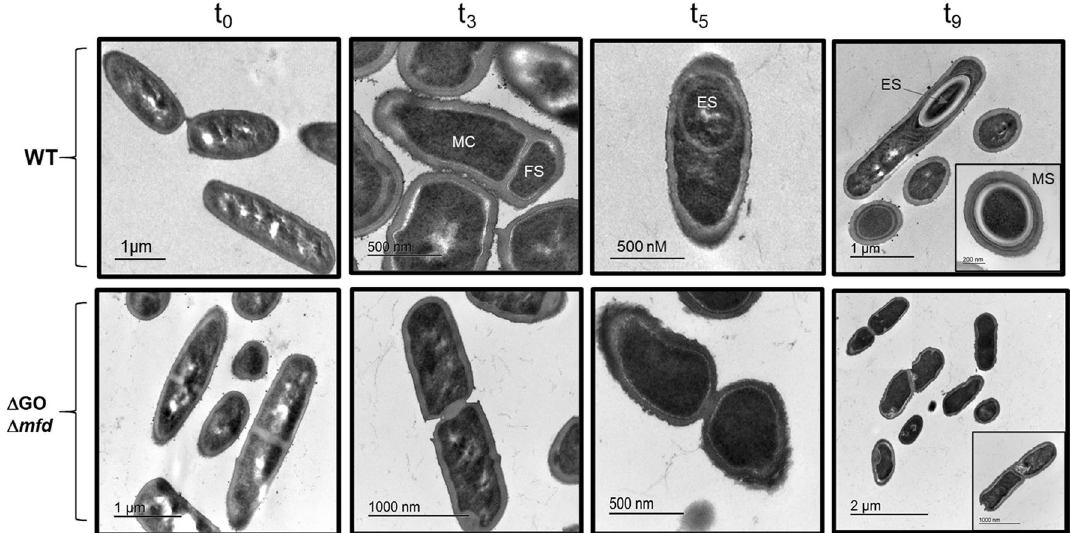
Figure 7. Transmission electron microscopy of sporulation stages of B. subtilis strains with a wild type (WT) or ∆ mfd ∆GO genotype. The strains indicated were induced to sporulate in DSM. At the stages indicated (t 0 , t 3 , t 5 and t 9 ), cells were collected, fixed and analyzed by TEM as described in “Materials and methods” section. Red arrows indicate: MC mother cell, FS forespore, ES endospore, MS mature spore. Insets in stage t 9 show: Upper panel, section of a mature spore; Lower pannel, section of an aberrant non-sporulated, divided cell. Scale bars as indicated in the